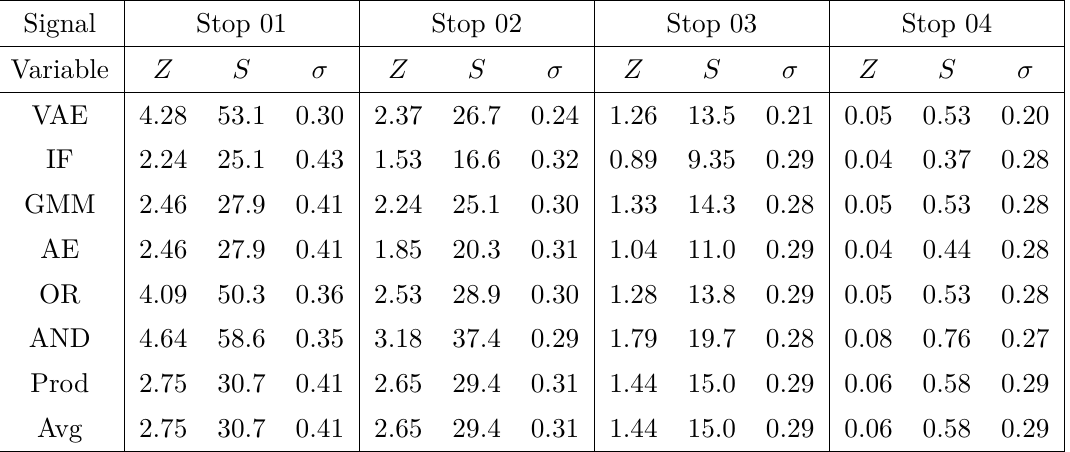
Table 6 . Table for algorithms applied on latent space representations. It shows Z -scores for the stop signals taken at 100 background events with no systematic uncertainty applied, the number of signal events ( S ) at said background cut, and the uncertainty on the background cut ( σ